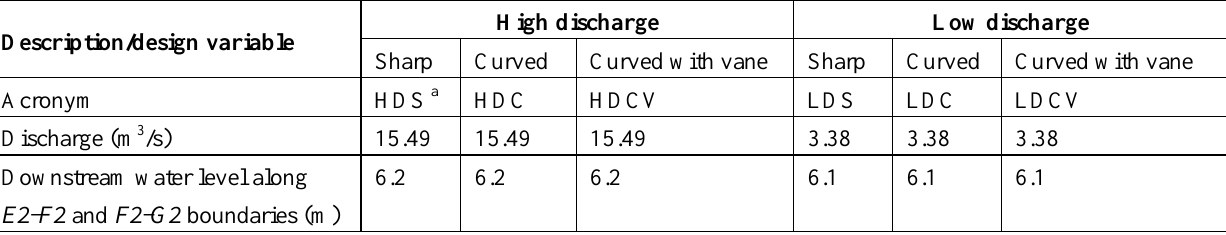
Table 1. Different flow